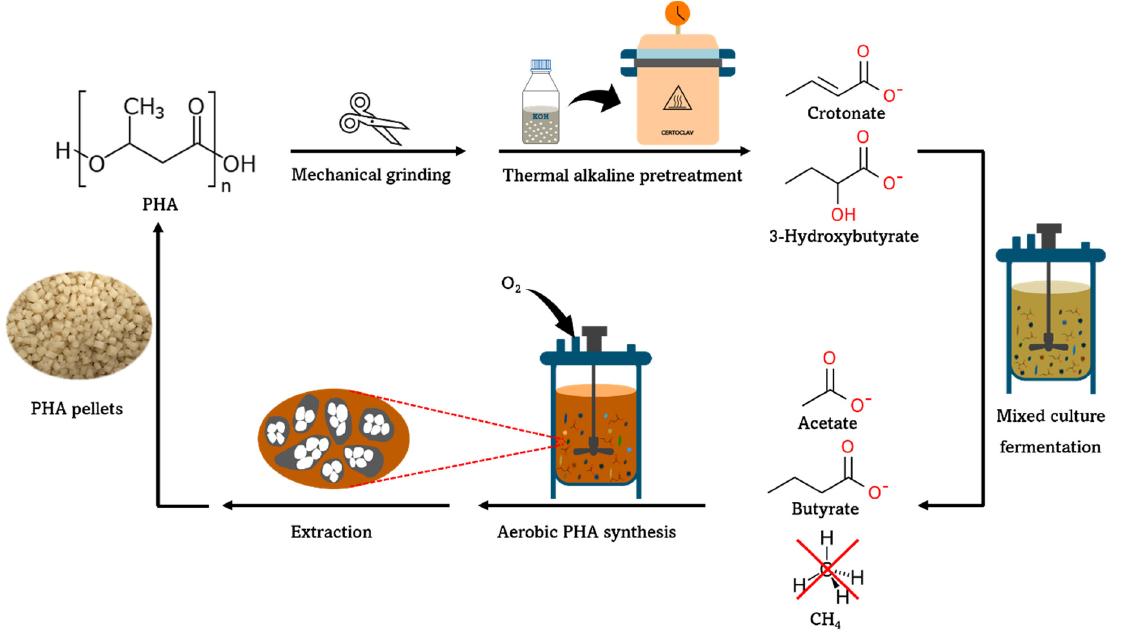
Figure 1. Proposed new route for recycling PHA via the formation of carboxylates after PHA application.